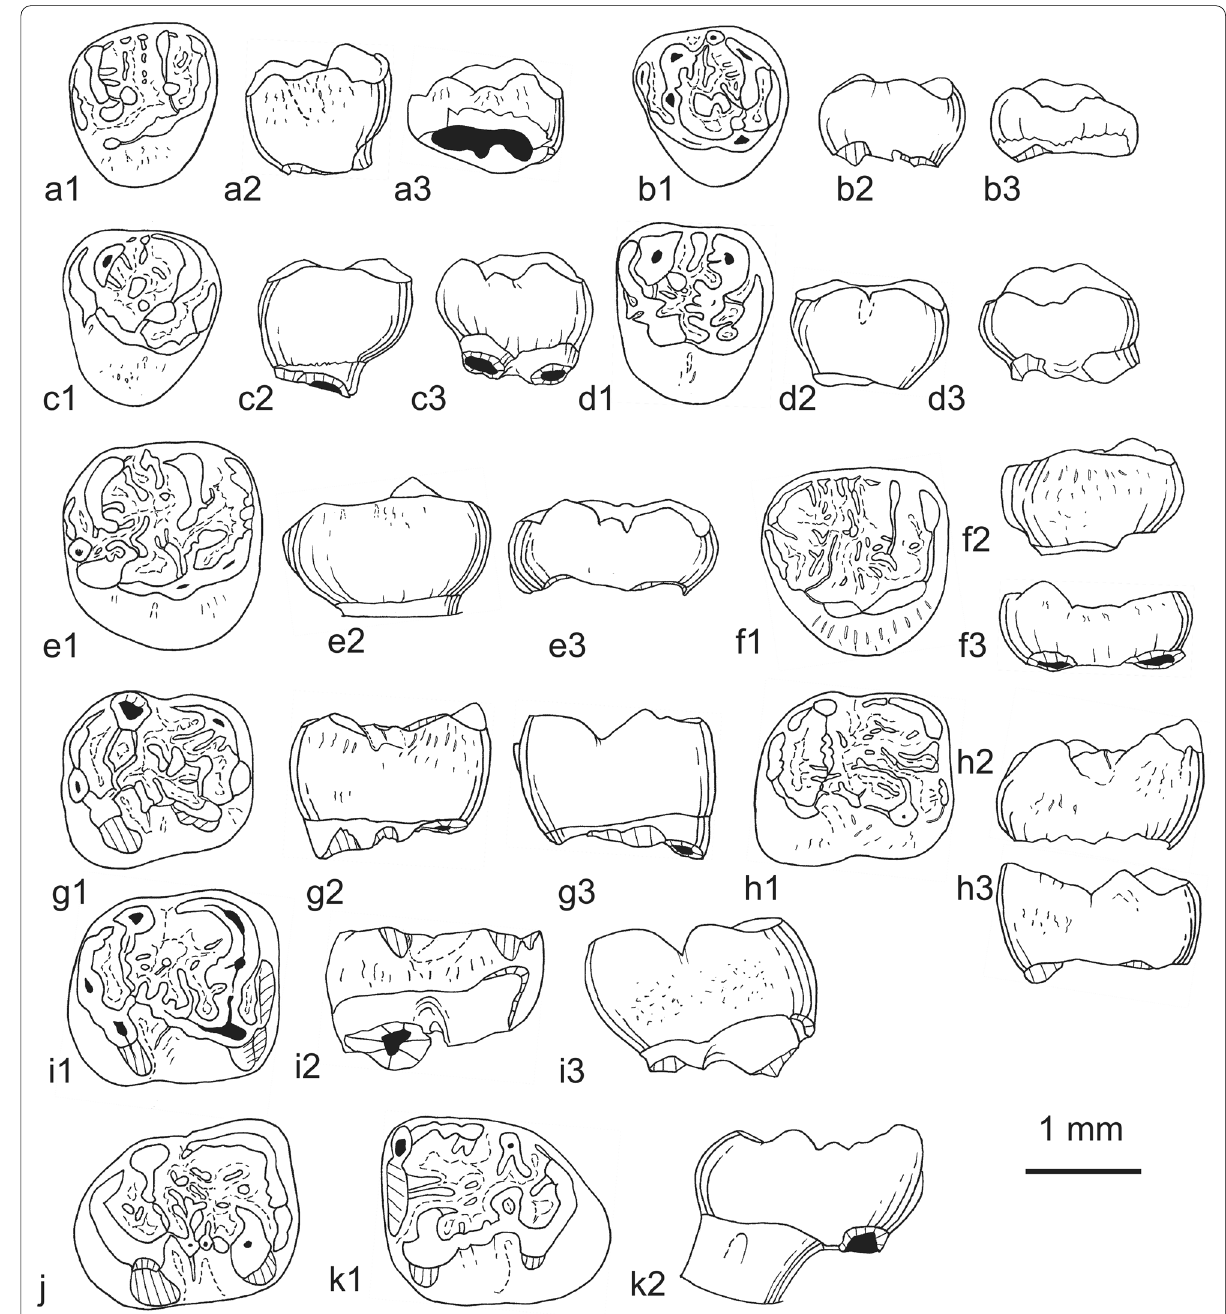
Fig. 40 Teeth of ? Protadelomys cf. alsaticus morphotype 3, from Bouxwiller (Bas‑Rhin). a CSBX2, right DP4; a1, occlusal view; a2, lingual aspect; a3, buccal aspect. b CSBX3, left DP4; b1, occlusal view; b2, lingual aspect; b3, buccal aspect. c : CSBX12, left P4; c1, occlusal view; c2, lingual aspect; c3, buccal aspect. d CSBX13, left p4; d1, occlusal view; d2, lingual aspect; d3, buccal aspect. e BUX67‑3, right M2; e1, occlusal view; e2, lingual aspect; e3, buccal aspect. f BUX67‑27, right M3; f1, occlusal view; f2, lingual aspect; f3, buccal aspect. g BW56‑59, right m1; g1, occlusal view; g2, buccal aspect; g3, lingual aspect. h BUX67‑129, right m1 or m2; h1, occlusal view; h2, buccal aspect; h3, lingual aspect. i BUX67‑142, right m2; i1, occlusal view; i2, buccal aspect; i3, lingual aspect. j : BSK‑A25, right m3; occlusal view. k : BUX67‑169, left m3; k1, occlusal view; k2, lingual aspect. Scale bar